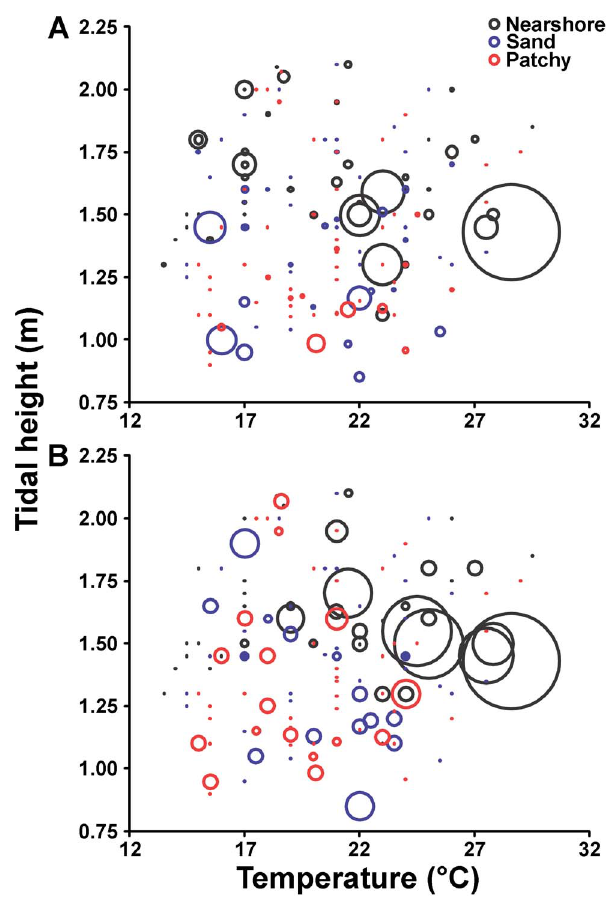
Figure 2. Ray densities. Bubble chart of giant shovelnose ray ( Glaucostegus typus ) (A) and whipray ( Himantura uarnak and H. fai ) (B) densities with tidal height, water temperature, and microhabitat. Bubble widths are relative to the maximum density observed for each species group (giant shovelnose ray: 22.67 rays ha 2 1 , whipray: 4.67 rays ha 2 1 ). Dots represent transects in which no rays were